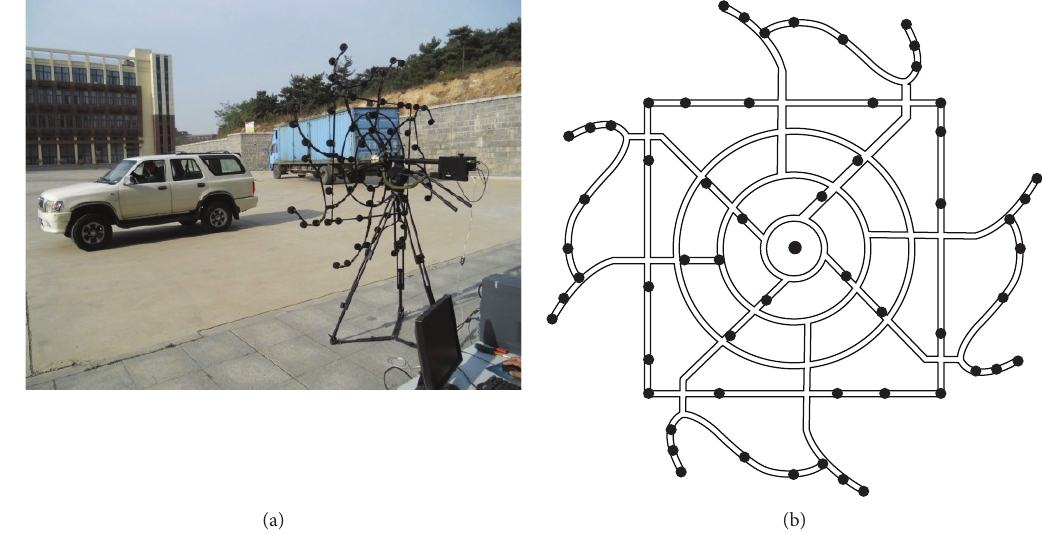
Figure 13: Experimental setup: (a) experimental photo; (b) microphone array.